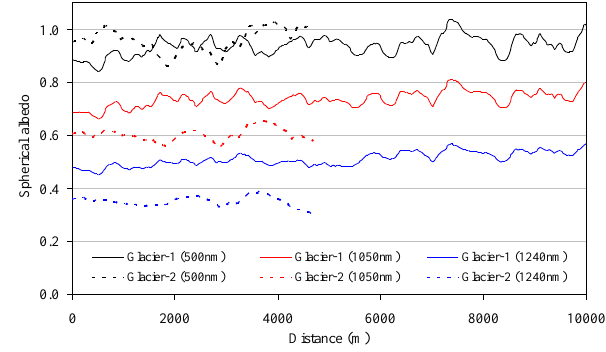
Fig. 12. The spatial profile of spectral albedo along the two selected Fig.12 glaciers of upper Himalaya (spatial profile marked as in Fig.